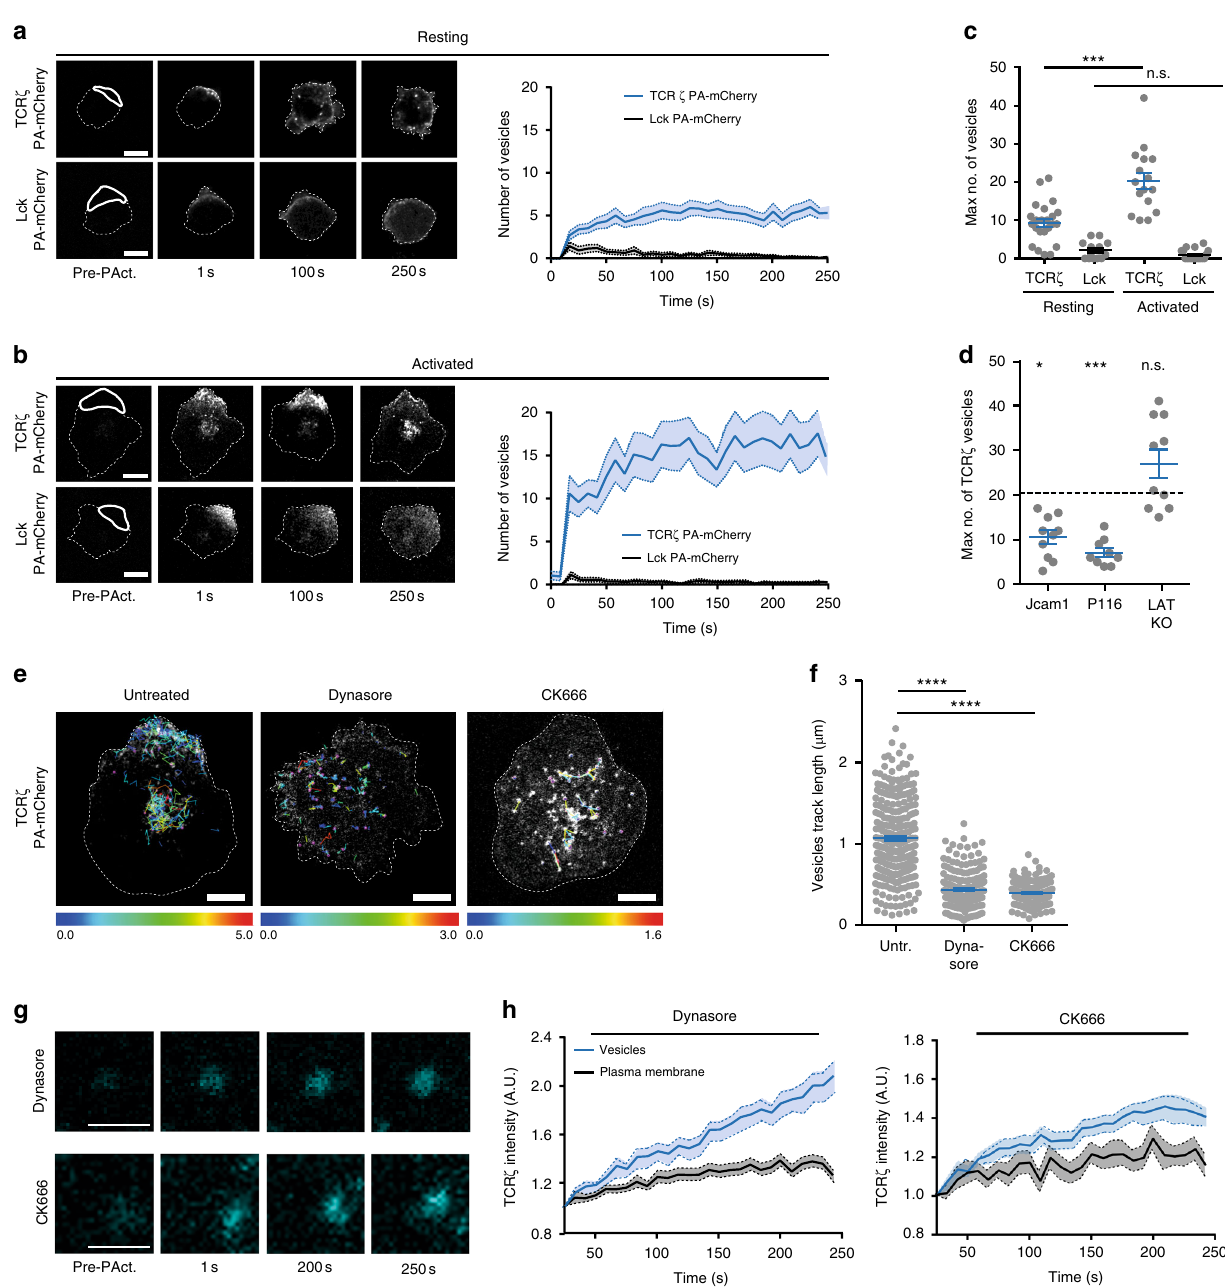
Fig. 1 T cell activation and signaling promote fast internalization of TCR ζ but not of Lck. a Left: Representative images of Jurkat T cells expressing TCR ζ -PA- mCherry (top panels) or Lck-PA-mCherry (bottom panels), allowed to adhere on non-activating (poly- L -lysine) or b activating (anti-CD3 ε and anti-CD28) surfaces, photoactivated on membrane region of interest and subsequently imaged for 250 s. Images show T cells before and after activation and at indicated time points. Right: number of PA-mCherry vesicles detected in each frame during the time of acquisition. c Maximum number of PA-mCherry vesicles detected in a given frame during the 250 s acquisition time. Each dot represents a cell. d Maximum number of PA-mCherry vesicles detected in Jurkat cells lacking functional Lck (JCam1), Zap70 (P116) or Lat (LAT KO) and activated on anti-CD3 ε and anti-CD28 coated surfaces. Horizontal dashed line represents the values for TCR ζ in activated cells from panel c. e Representative examples of TCR ζ -PA-mCherry vesicle tracks detected in activated untreated cells or treated with dynasore or CK666. Color scale is length in µ m. f Length of vesicle tracks in untreated, dynasore or CK666 treated cells. Each dot is one track. g Zoomed images of immobile TCR ζ -PA-mCherry vesicles in dynasore (top) or CK666 (bottom) treated Jurkat T cells. Scale bar is 0.5 µ m. h Fluorescence intensity pro fi les over time of single vesicles, such as those shown in g and neighboring plasma membrane regions of the same size. Scale bars, 5 µ m. Data obtained from three or more independent experiments. Small horizontal lines indicate mean (±SEM). ns, not signi fi cant; * p <